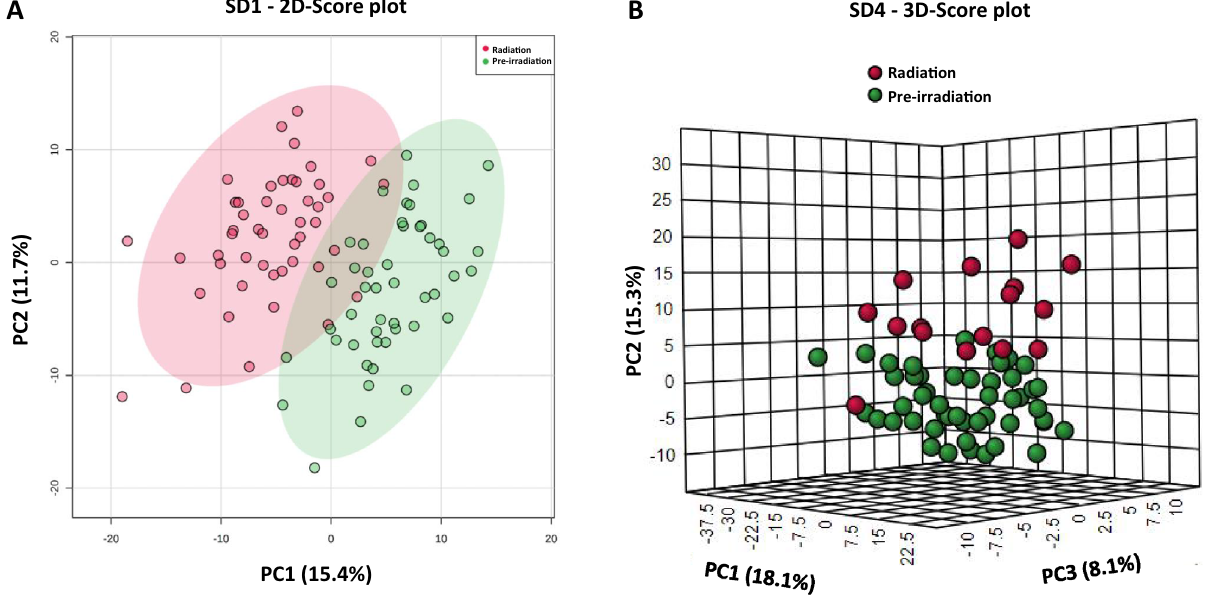
Figure 2. Exposure to 60 Co gamma-radiation induces short term changes in serum metabolic profiles in NHPs. Panel A. First two-principal components two dimensional score plot for NHPs at SD1. Panel B. First three- principal components 3D score plot for NHPs at SD4. Figure is created by open source software MetaboAnalyst (version 5.0, URL: https:// www. metab oanal yst.